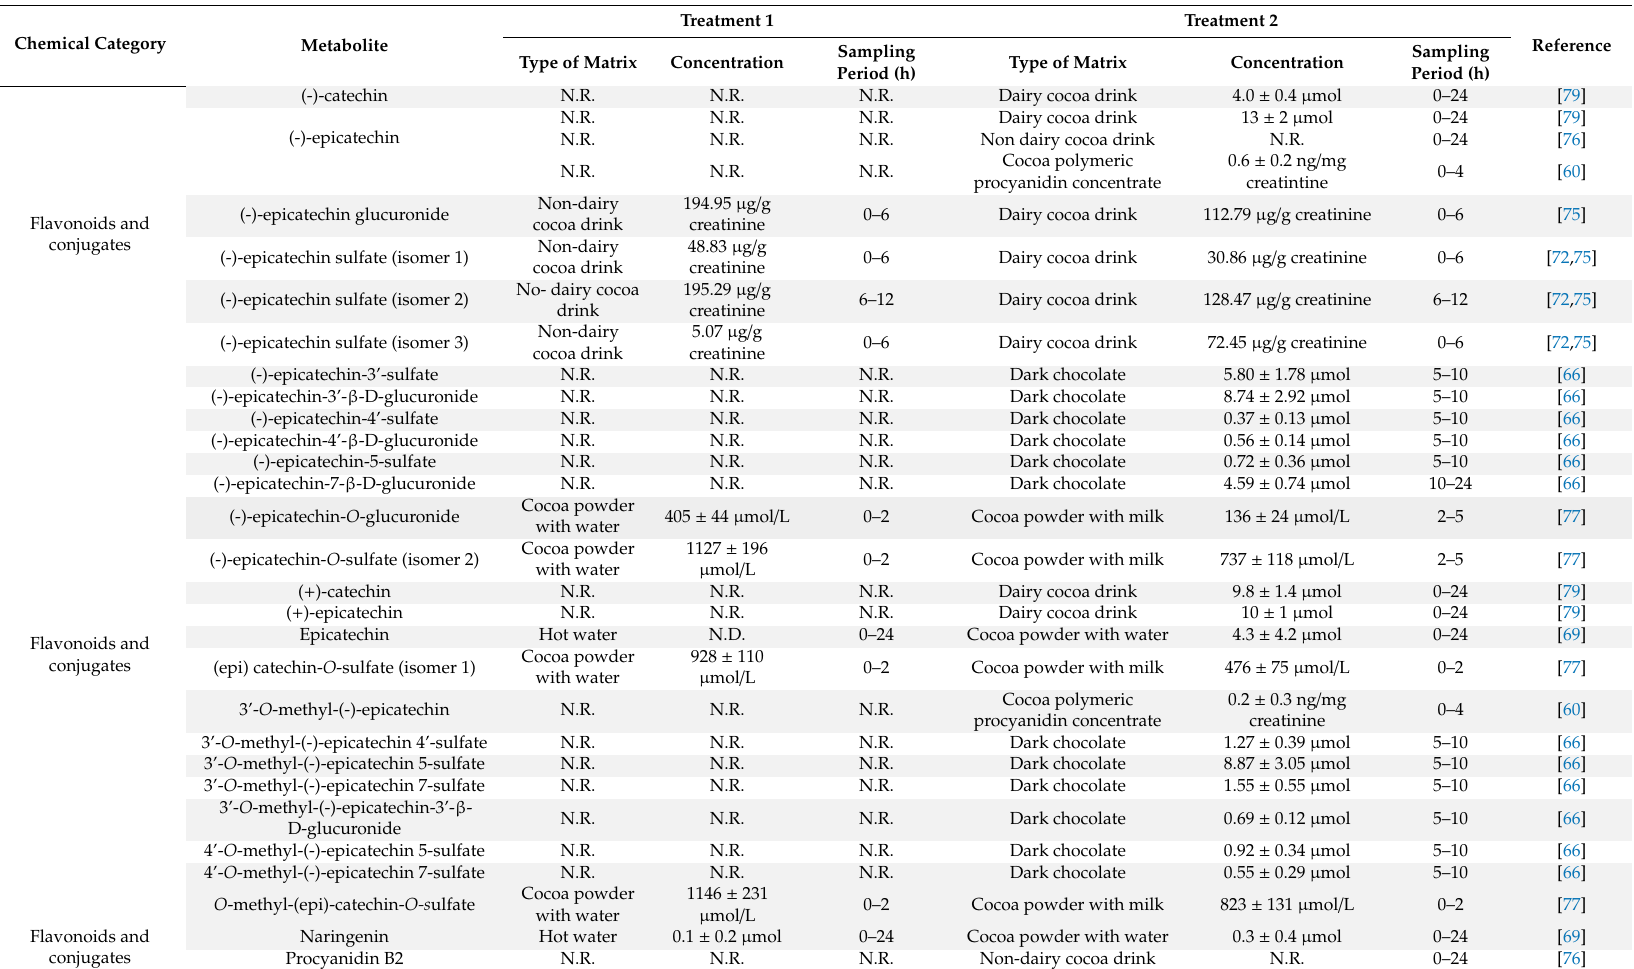
Table 6. Metabolites analyzed in urine after acute cocoa interventions and studied with targeted